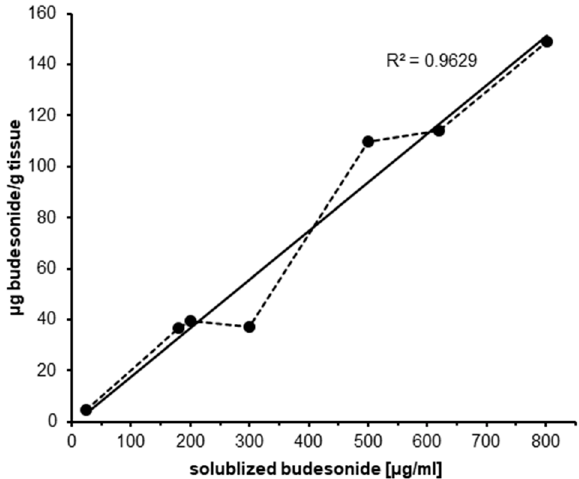
Figure 3. Relationship of permeated vs. applied concentration of solubilized budesonide. The amount of permeated budesonide (µg/g tissue, y -axis) measured in porcine mucosa samples (expressed as mean of n = 3–5) after 30 min of incubation with Budesolv formulations containing different concentrations of solubilized budesonide (µg/mL, x -axis). The correlation coefficient R 2 was calculated by linear regression, for which the trend line is displayed. The data from several individual experiments were used to generate this general relationship.